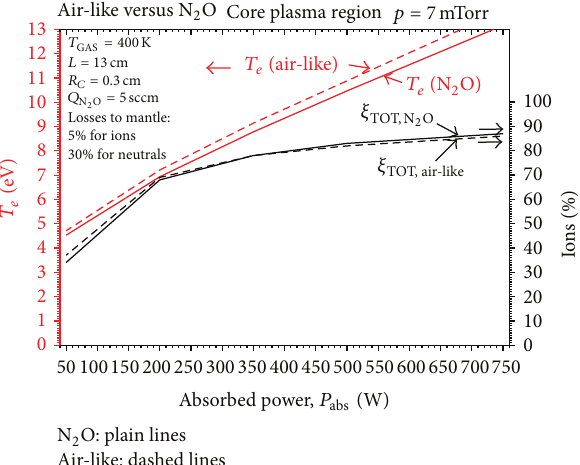
linesN 2 O: plain lines Air-like: dashed Figure17: Comparisonofthevariations of 𝑇 𝑒 ,ionization percentage forthe“core”regionofaN 2 Ofed,andofanairfedHPT,asafunction of absorbed power for 7mTorr.